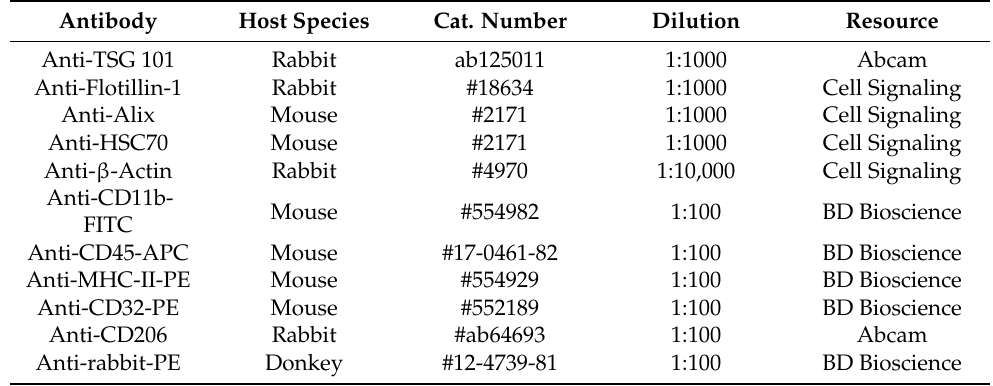
Table 1. Primary